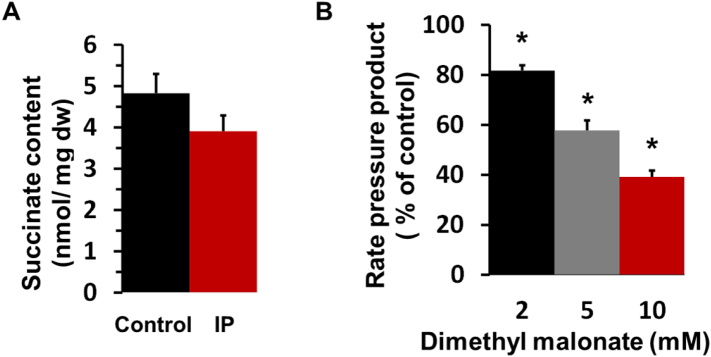
IP does not attenuate succinate accumulation in ischemia while dimethyl malonate impairs the hemodynamic performance of the Langendorff-perfused heart.Panel A shows the succinate content (nmol per mg dry weight; mean ± SEM, n = 6) of freeze clamped control (CI) and IP (IPI) hearts following 30 min global ischemia; values in normoxic hearts were below our limit of detection (< 0.5 nmol per mg). Data are taken from [7]. Panel B shows that the Rate Pressure Product (RPP) of normoxic Langendorff-perfused rat hearts was decreased by the presence of increasing concentrations of dimethyl malonate (DMM). Data are expressed as a percentage of values in the absence of DMM (29,900 ± 2800 mmHg*beat/min) and are given as means ± SEM (error bars) of 7 hearts. Statistical significance was determined by paired Student's t-test (*p < 0.01).